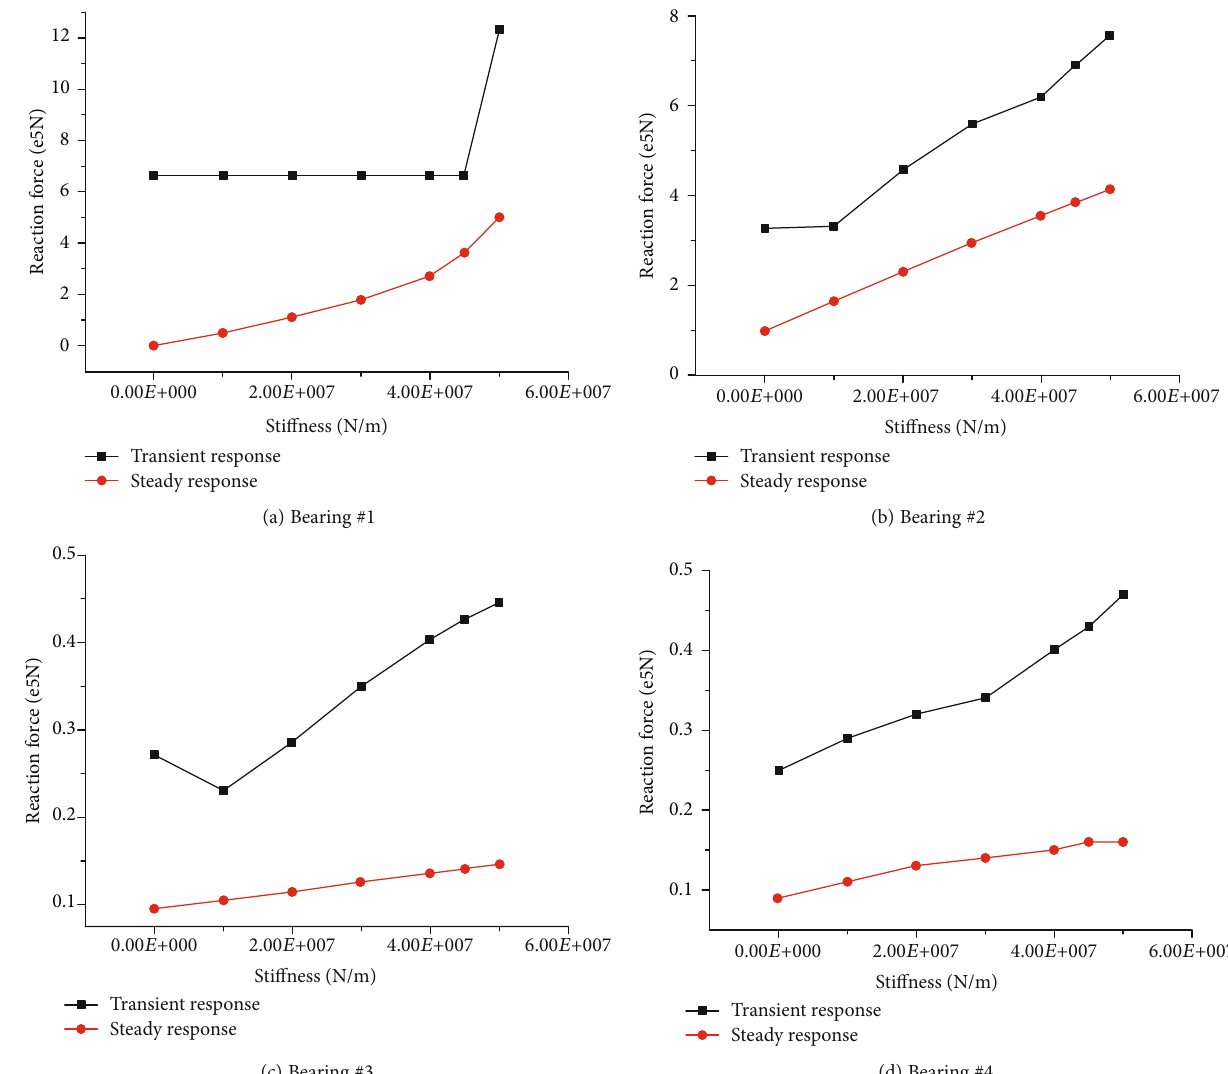
Figure 18: Reaction force change with reduction in residual sti ff ness of bearing